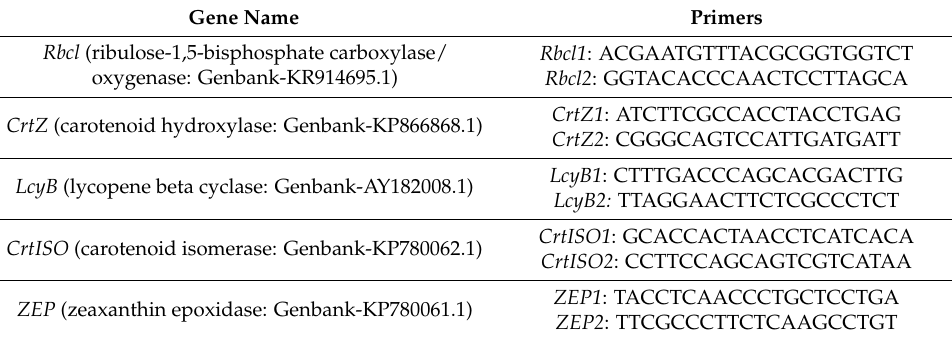
Table 7. Primers used for